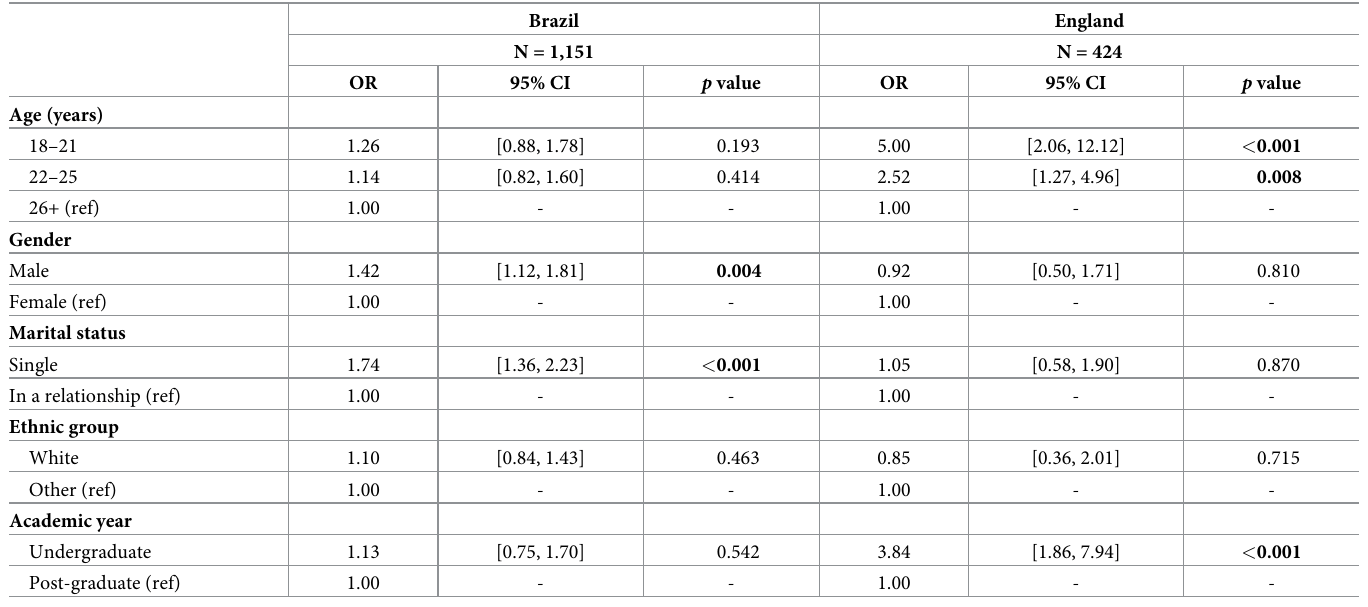
Table 4. Factors associated with pre-drinking amongst Brazilian and British university